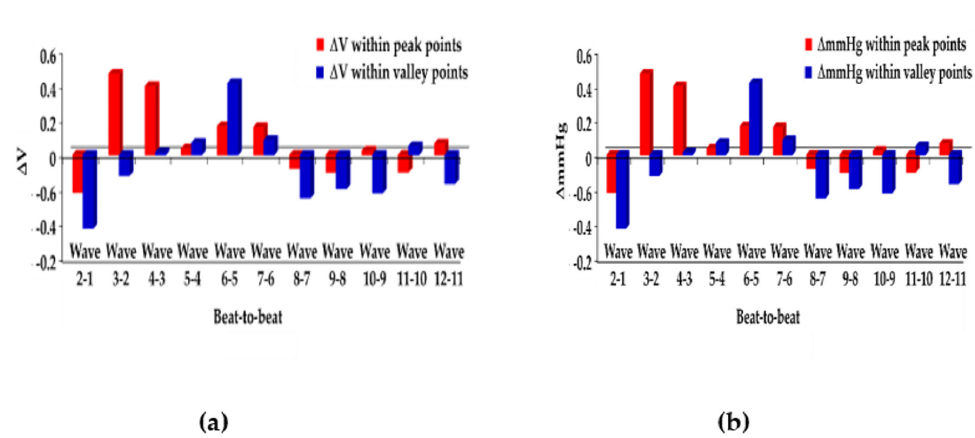
Figure 9. ( a ) The voltage change and ( b ) pressure change within feature points of SBP and